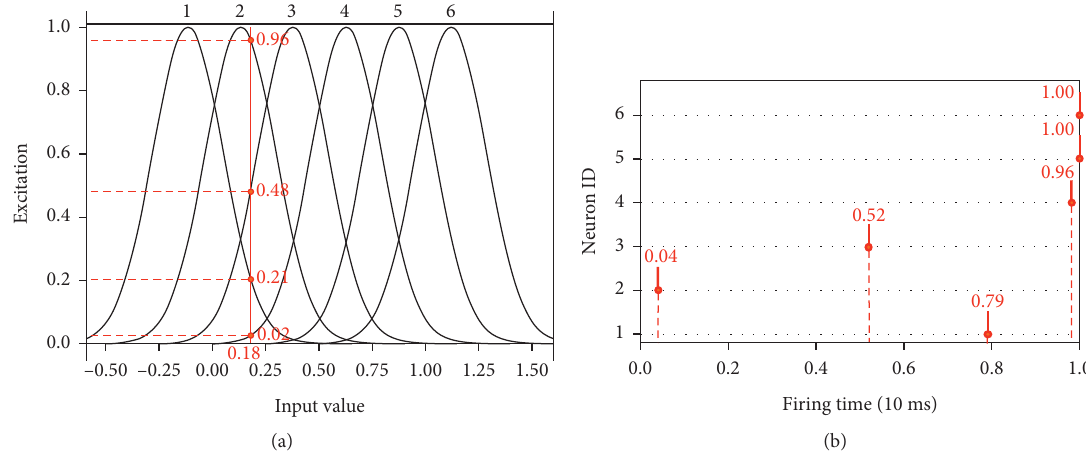
Figure 4: Accident attribute coding with Gaussian tuning curve. (a) The corresponding Gaussian curve of six neurons. (b) Firing time of six neurons.